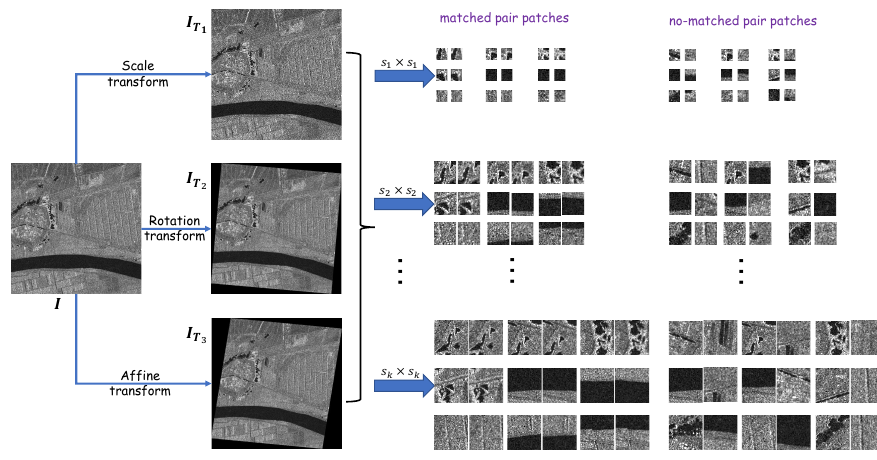
Figure 3. An example of constructing training sets with multiple